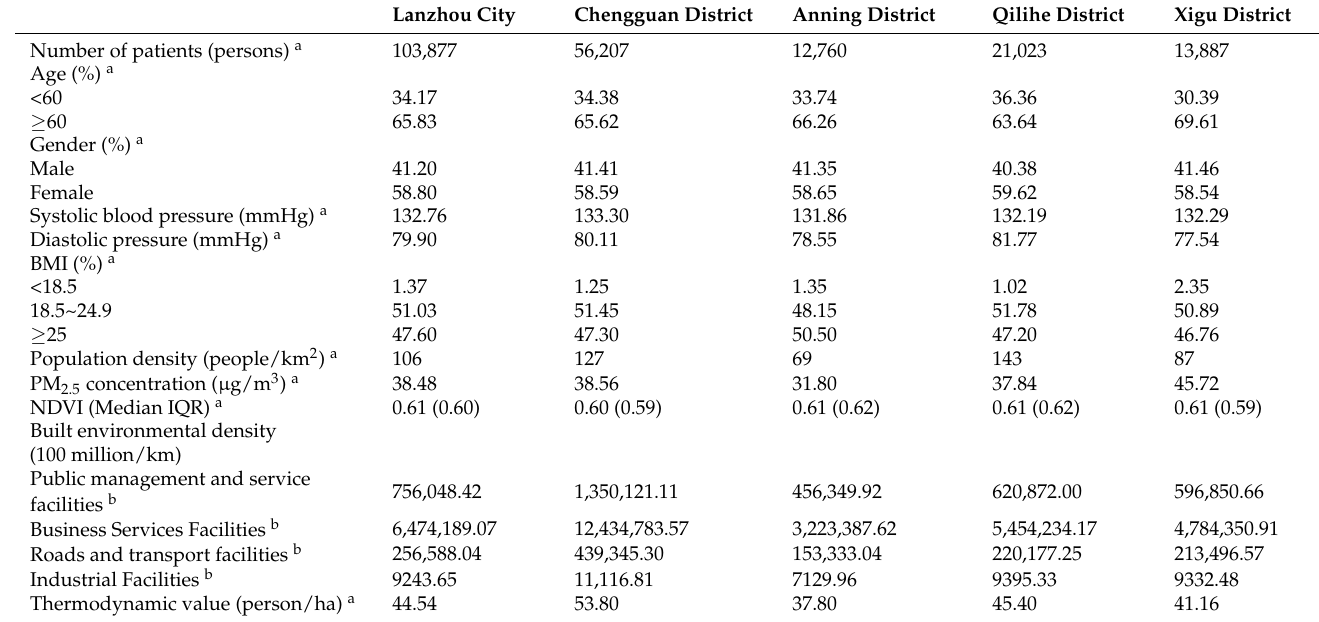
Table 1. Deprivation index system of residential environment setting.